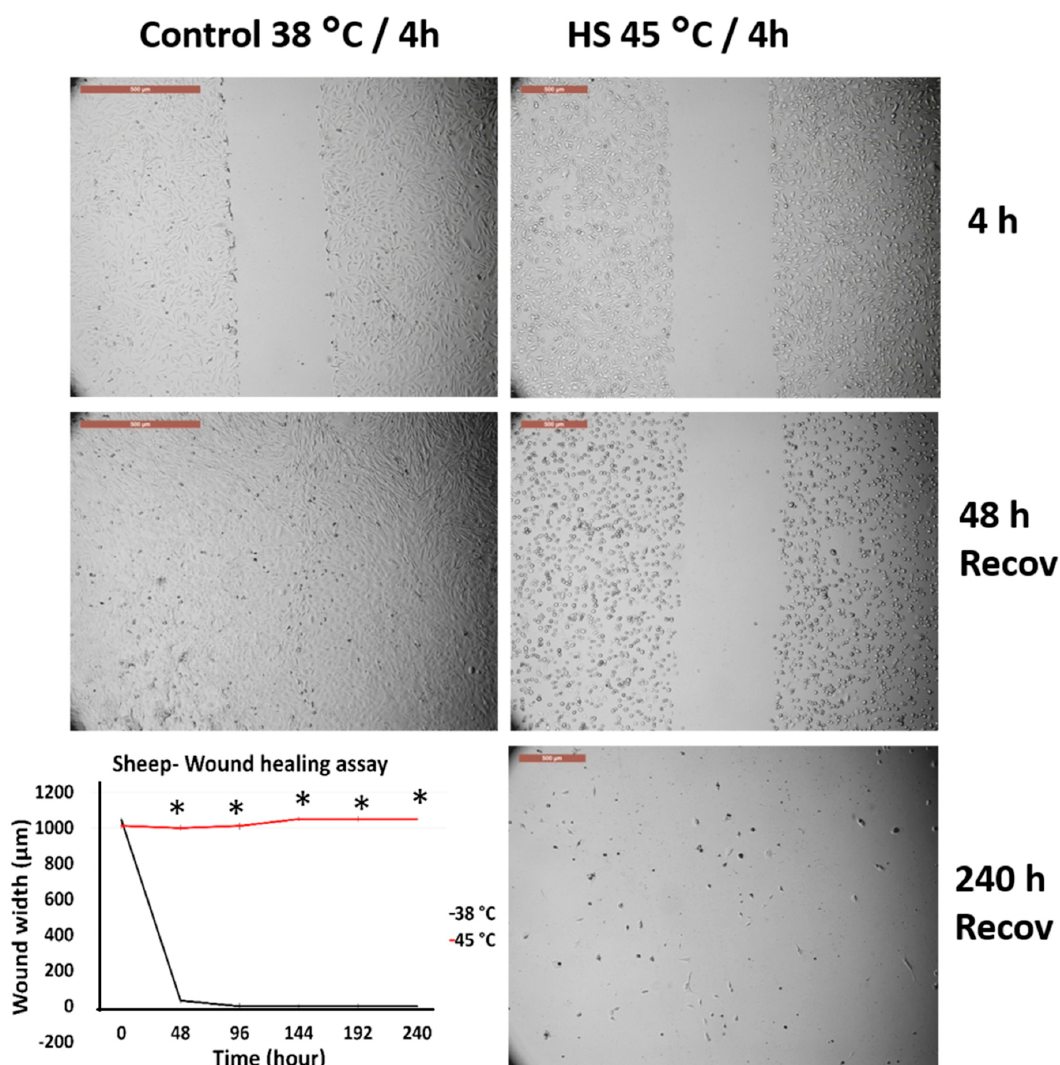
Figure 7. Wound healing (cell scratch) assay for sheep first passage fibroblasts exposed to 45 ◦ C for 4 h and control cells (38 ◦ C for 4 h). Cells were incubated under the required conditions, recovered at 38 ◦ C, and monitored daily for wound closure. Scale bar = 500 µ m. Data are presented as means ± SEM, values of the same timings were analyzed using Student’s t -test, and asterisks (*) indicate significant differences at p < 0.05.